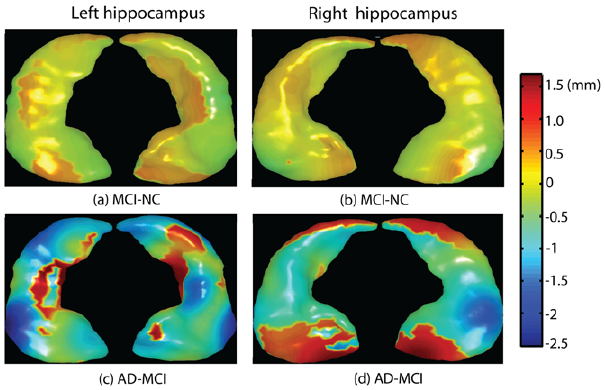
Figure 2. Hippocampal shape differences among normal controls (NC), mild cognitive impairment (MCI), and Alzhei- mer’s Disease (AD). Panels (a,b) respectively show group differences in the left and right hippocampal surface deformations between MCI and NC. Panels (c,d) respectively show group differences in the left and right hippocampal surface deformations between AD and MCI. Warm color denotes regions where structures have surface outward-defor- mation in the former group when compared with the latter group, while cool color denotes regions where structures have surface inward- deformation in the former group when compared with the latter group.